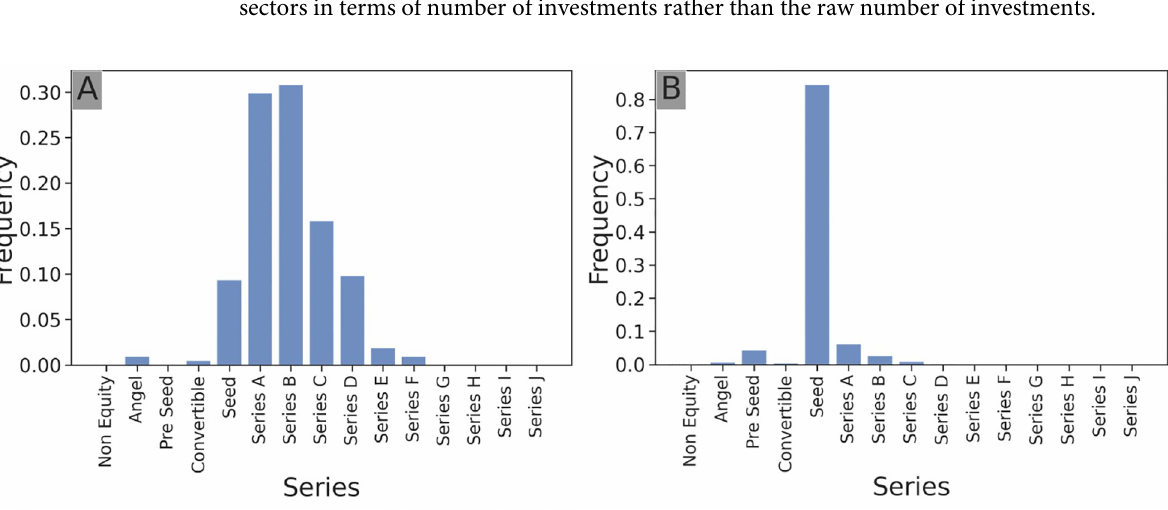
Fig 5. Stage investment distribution. Stage investment distribution of Softbank Capital ( A ) and Y Combinator ( B ). Softbank Capital shows a strong focus in late-stage investment (most of its investments are in Series B or later) whereas Y Combinator shows a very strong early-stage specialization (over 80% of its investments in Seed